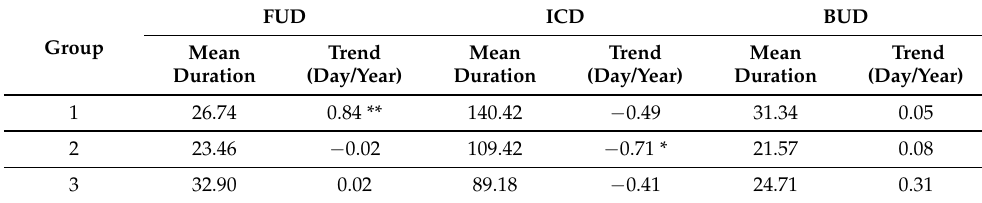
Figure 5. Temporal change and trends of lake ice phenology variables from 2002 to 2020 of three elevation groups. ( a ) Freeze-up start day; ( b ) freeze-up end day; ( c ) breakup start day; and ( d ) breakup end day. Table 4. Lake ice process duration change and